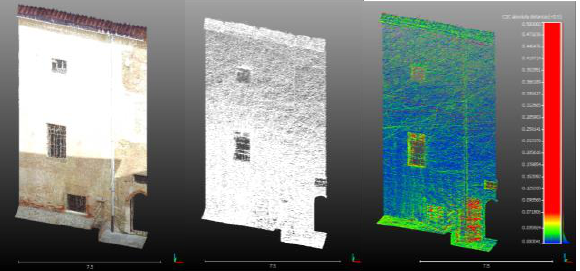
Figure 15. Comparing ZebRevo cloud to the LiDAR cloud. (1÷2cm for plane surface, 5÷7 cm for distant or articulated